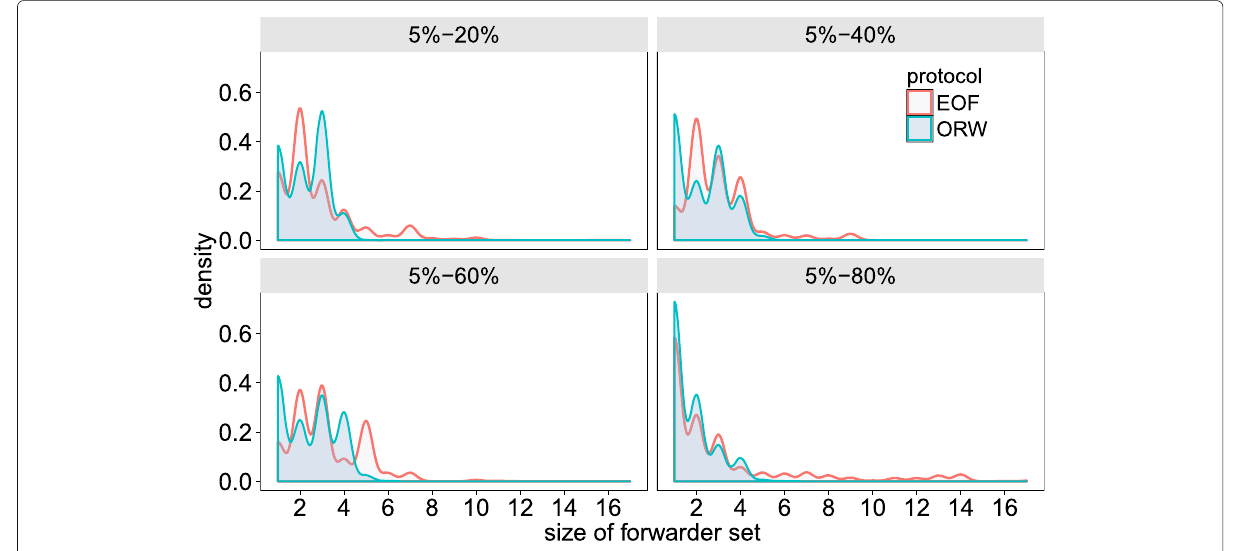
Fig. 9 Comparison of forwarder set’s